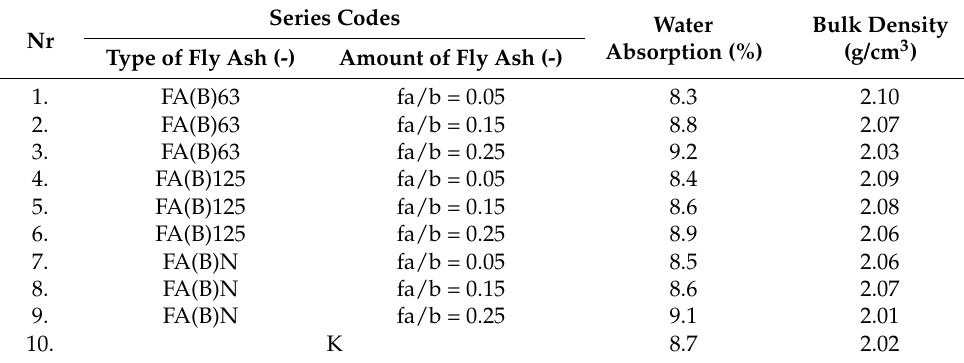
Series Codes Water